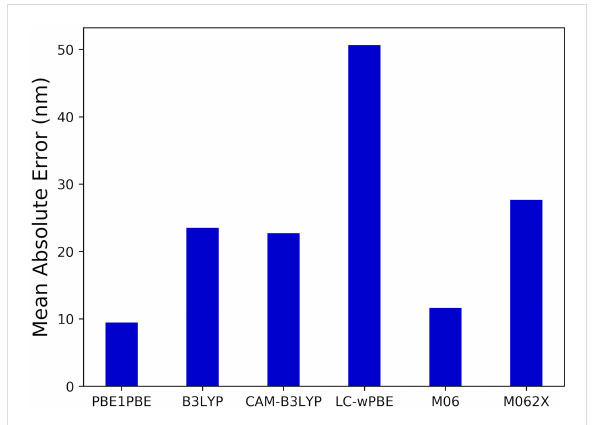
Figure 2: (Left) UV–vis, (center) fluorescence emission and (right) solvatochromic effect (Stokes shift in wavenumbers versus solvent polarity in ETN) of the synthesized BTD-4APTEG (10 μ M for all analyses).